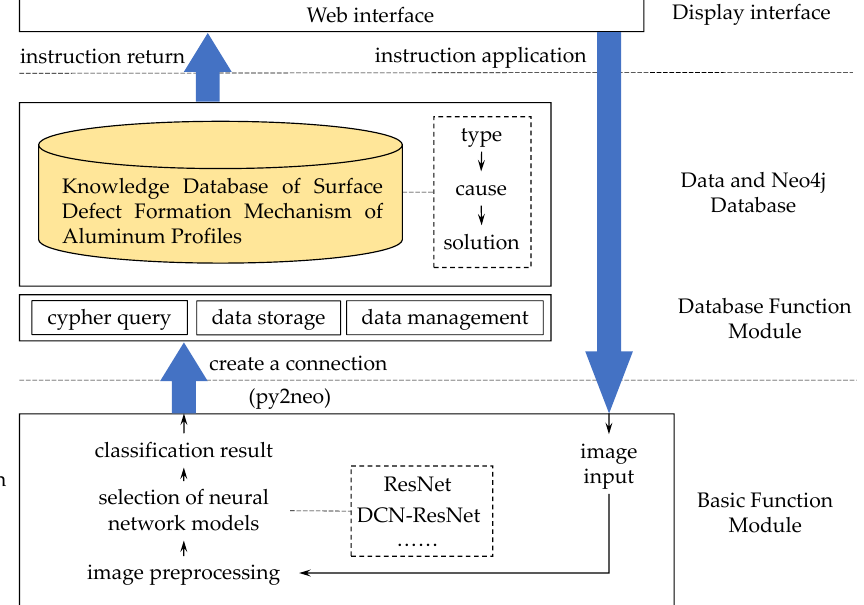
Figure 16. Three-tier architecture of visual system based on B/S mode.